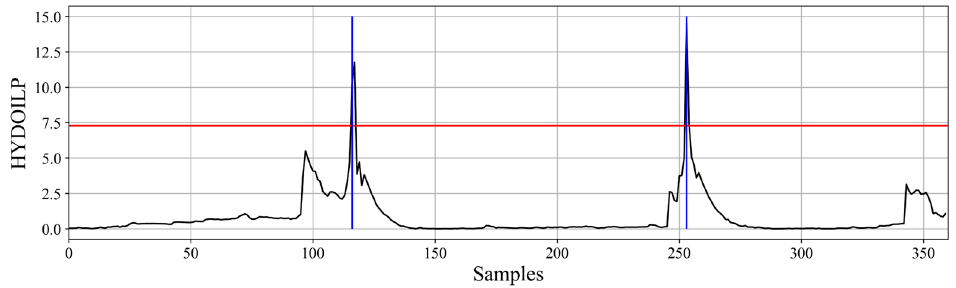
Figure 2. Signal of hydraulic oil pressure from cargo box unloading system for haul truck along with detection threshold (red) and detected unloading moments (blue).